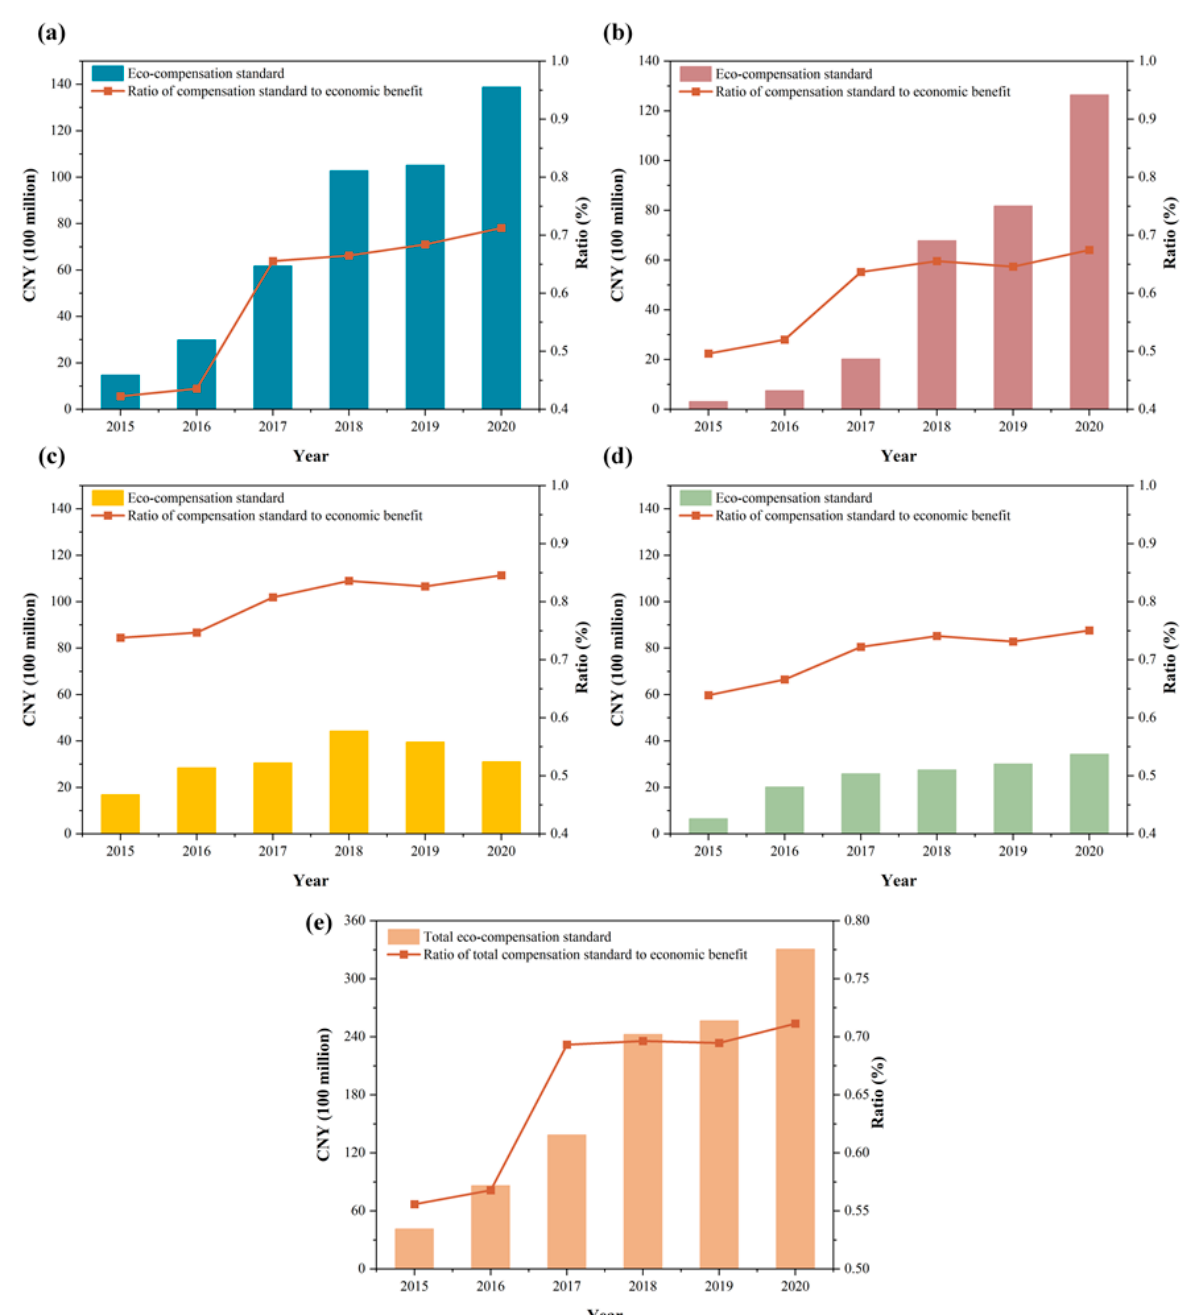
Figure 7. Changes in the eco-compensation standards of ( a ) Henan, ( b ) Hebei, ( c ) Beijing, and ( d ) Tianjin in the receiver areas from 2015 to 2020 and ( e ) all receiver areas.